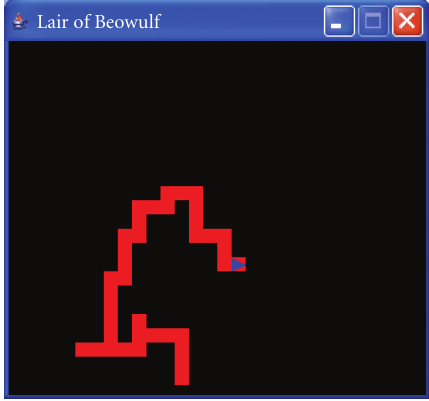
Figure 2: The revealing